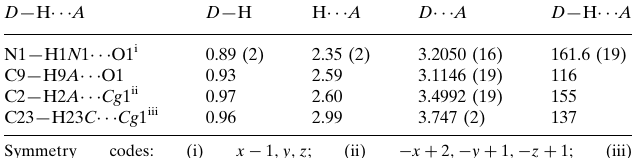
Hydrogen-bond geometry (A˚ , (cid:1)